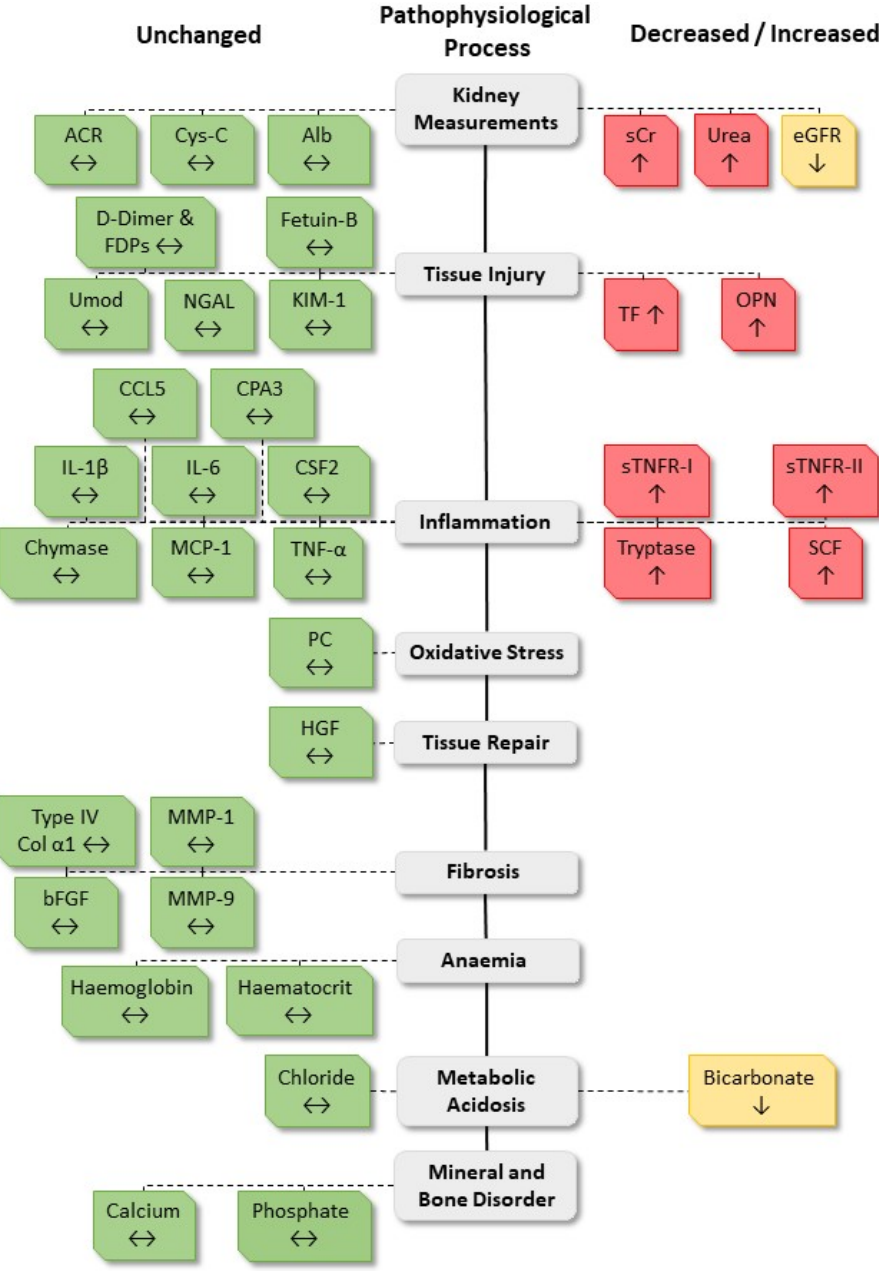
Figure 3. Biomarker expression that differed between progressive and non-progressive patients of the Predictive Model cohort. A schematic diagram of the 37 biomarkers screened in the Predictive Model cohort and whether the concentration was increased (red), decreased, or unchanged (green) between progressive and non-progressive patients. Abbreviations: Albumin-creatinine ratio (ACR), cystatin-c (Cys-C), albuminuria (Alb), serum creatinine (sCr), estimated glomerular filtration rate (eGFR), fibrin degradation products (FDPs), uromodulin (Umod), neutrophil gelatinase-associated lipocalin (NGAL), kidney injury molecule-1 (KIM-1), chemokine ligand 5 (CCL5), carboxypeptidase A3 (CPA3), interleukin (IL), colony-stimulating factor 2 (CSF2), monocyte chemoattractant protein-1 (MCP-1), tumour necrosis factor (TNF), soluble TNF receptor (sTNFR), stem cell factor (SCF), protein carbonyl (PC), hepatocyte growth factor (HGF), collagen (Col), matrix metalloproteinase (MMP), basic fibroblast growth factor (bFGF).